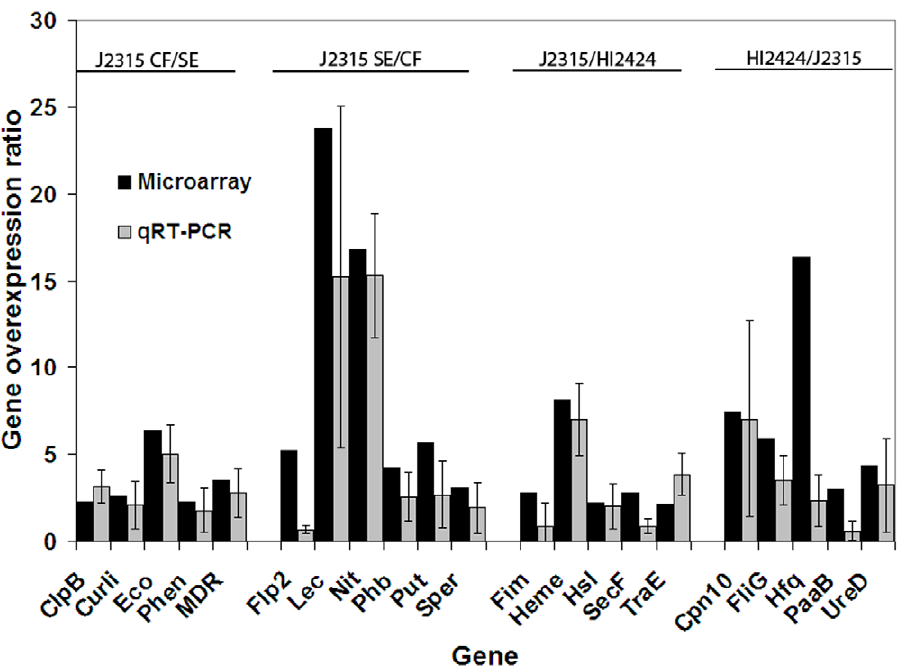
Figure 5. Quantitative real-time PCR verification of microarray data. Twenty-two genes were tested for gene expression ratios and plotted as ratios (either J2315 CF/SE or J2315/HI2424). Error bars correspond to a single standard deviation of the data.